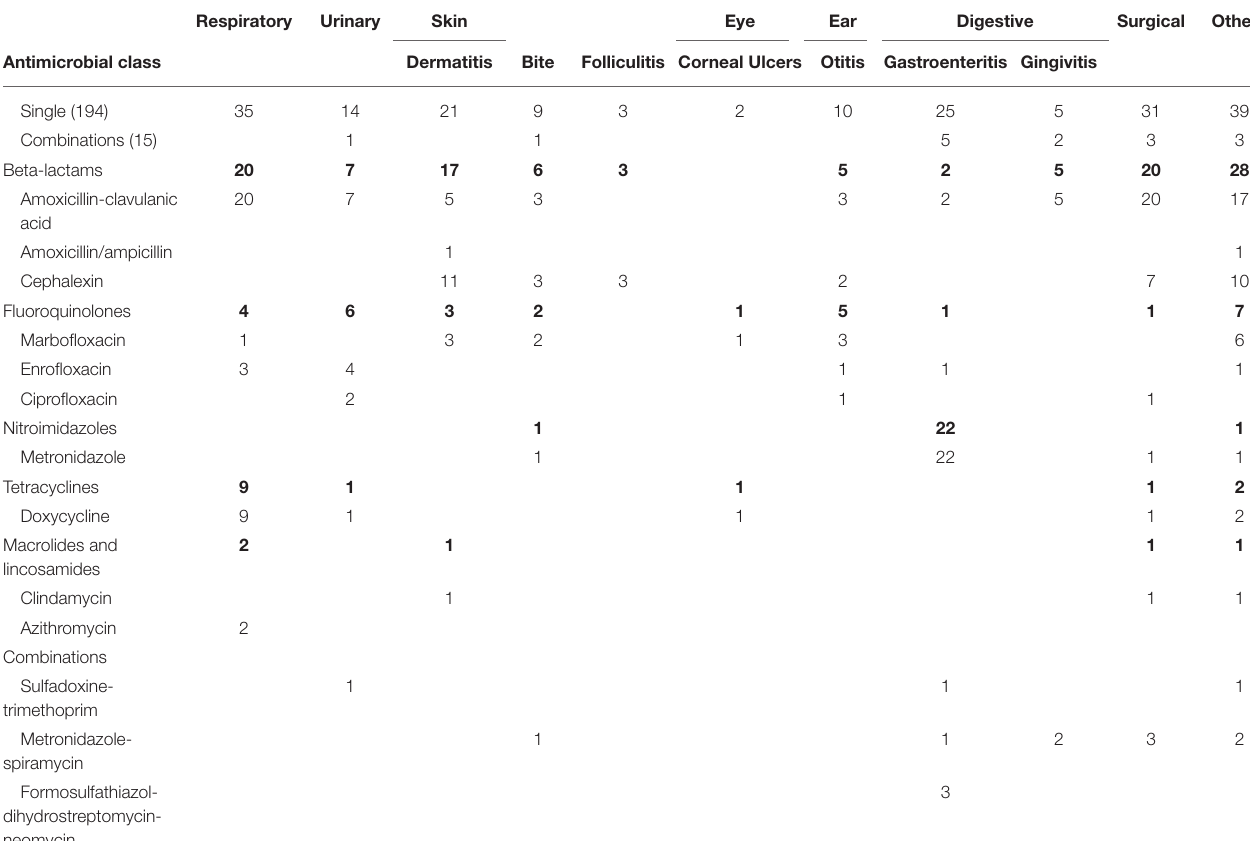
TABLE 2 | Distribution of antimicrobials of 209 oral medicinal products according to organ/system (conditions) treated, on 300 urban dogs (Madrid City). Respiratory Urinary Skin Eye Ear Digestive Surgical Others Antimicrobial class Dermatitis Bite